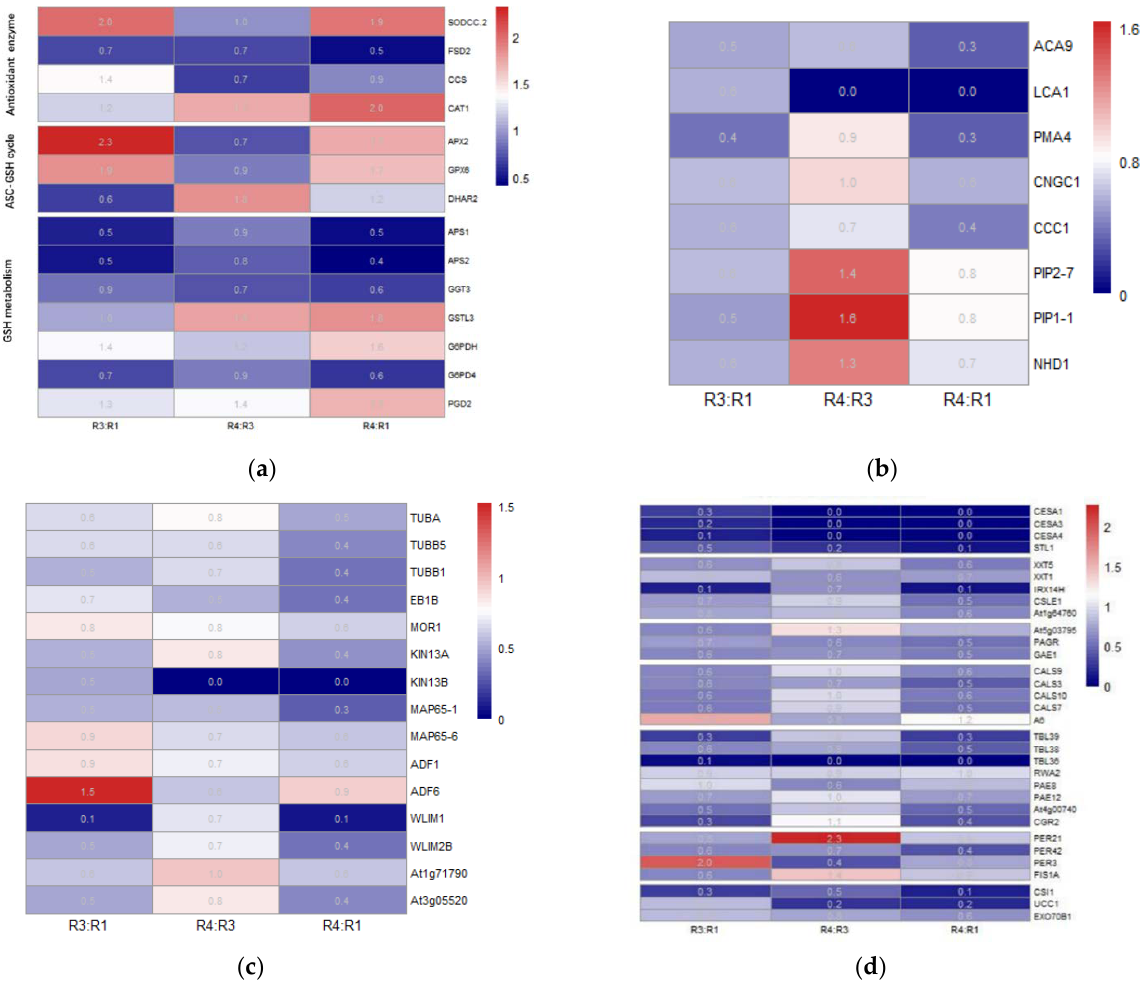
Figure 8. Heatmap of key DEPs. The shades of blue reflect the degree of decrease in protein expression ( − ve), while the shades of red reflect the degree of increase in protein expression (+ve). ( a ) REDOX related DEPs. ( b ) Ion channel-related DEPs. ( c ) Cell skeleton-related DEPs. ( d ) Cell wall-related DEPs.